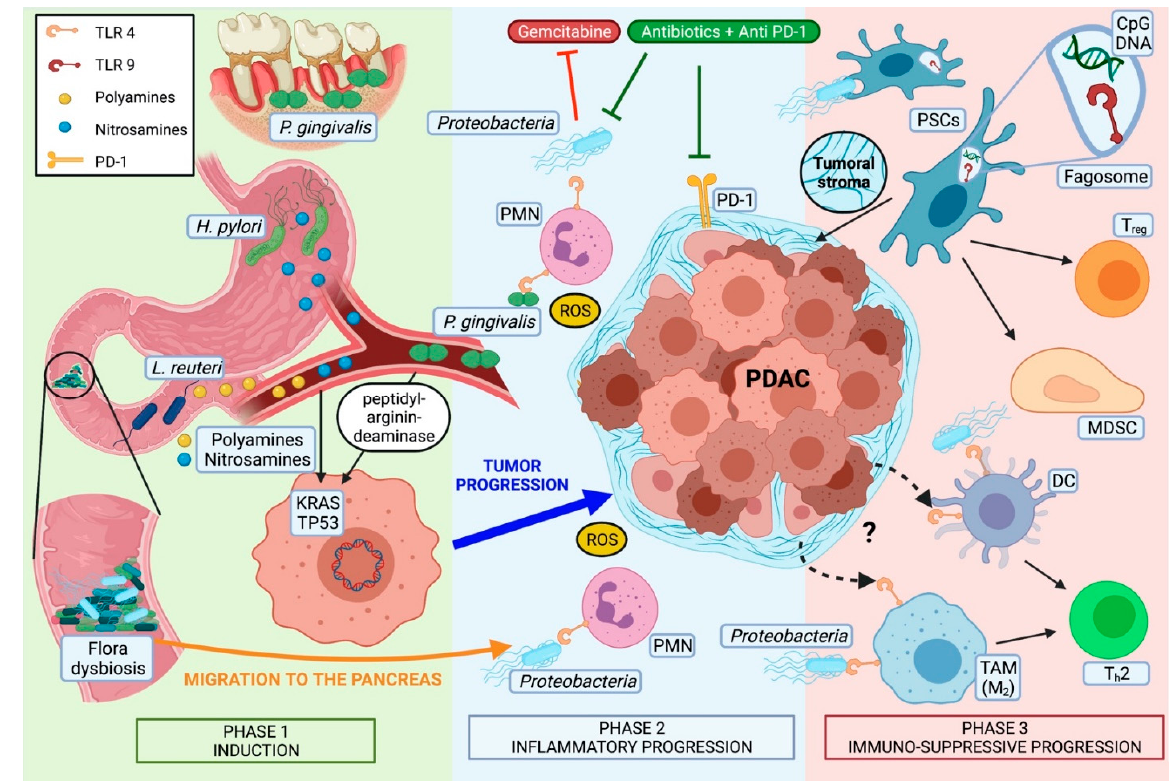
Figure 1. Proposed model of microbial dysbiosis driven pancreatic carcinogenesis. Phase 1: The tumor induction in the case of flora dysbiosis is related to the production of different substances that can be responsible for point mutations of genes like KRAS and TP53 of pancreatic ductal cells (e.g., polyamines produced by H. pylori and L. reuteri , or the enzyme peptidyl-arginine-deaminase of P. gingivalis ). Phase 2: Tumor progression after the proliferation of the first cell-clone is sustained by bacterial-induced inflammation. Dysbiosis of the gut flora and alterations of the intestinal wall permeability originate from diet-disbalance and finally facilitate the migration of microorganisms into the pancreas. In particular, the translocation of Gram-negative bacteria elicits an inflammatory response. This one occurs when PMNs recognize bacterial LPS via TLR4 with consequent production of ROS. In this way, the establishment of an oxidative stress disbalance sustains the carcinogenic process. Phase 3: Intrapancreatic mechanisms of receptor-related molecular feedback lead for a second time to a switch of the immune response towards a tolerogenic phenotype. In particular, the activation of TLR4 expressed by DCs and M2-polarized TAM induces T h 2-deviated CD4 + cells. However, it is still unclear if this receptor function of TLR4 depends on binding of either bacterial LPS or other uncharacterized tumoral products (marked with “?” in the picture) [47,48]. Furthermore, the activation of TLR9, an essential receptor for the recognition of CpG bacterial-DNA expressed on PSCs, stimulates the production of fibrous stroma and the expression of CCL11, a mediator with pro-tumorigenic effects on pancreatic ductal cells. TLR9 activation also leads to the PSC-dependent recruitment of T reg and MDSCs in the TME [49]. Abbreviations: DC: dendritic cell; MDSC: myeloid-derived suppressor cell; PMN: polymorphonuclear cells; PSCs: